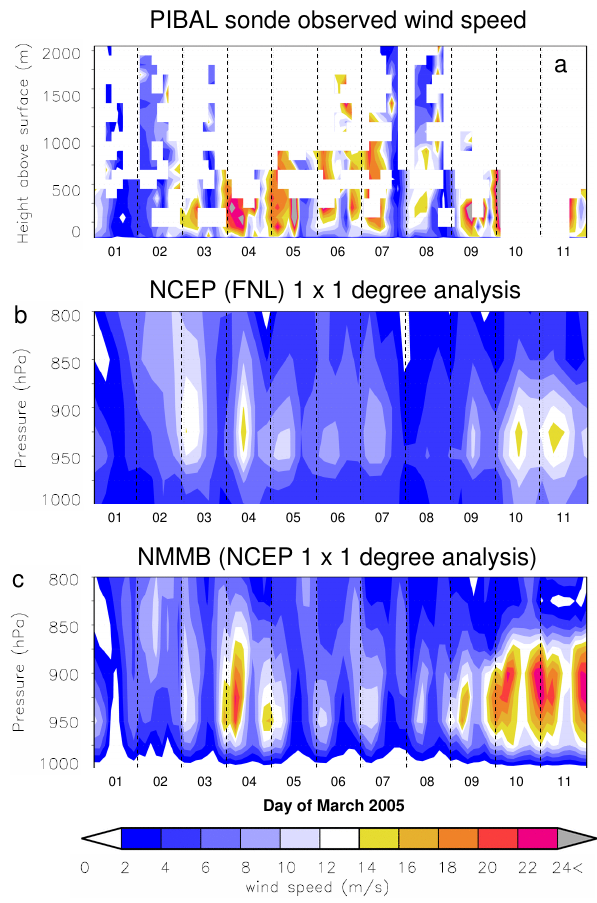
Fig. 17. Time-height profile of wind speed (ms − 1 ) at Chicha as de- rived from PIBAL balloon data (a) , NCEP analysis 1 ◦ × 1 ◦ data (b) and NMMB/BSC-Dust initialized with NCEP analysis and GLDAS soil conditions (c) for the period from 1–11 March 2005. Note that height units are either given in m or